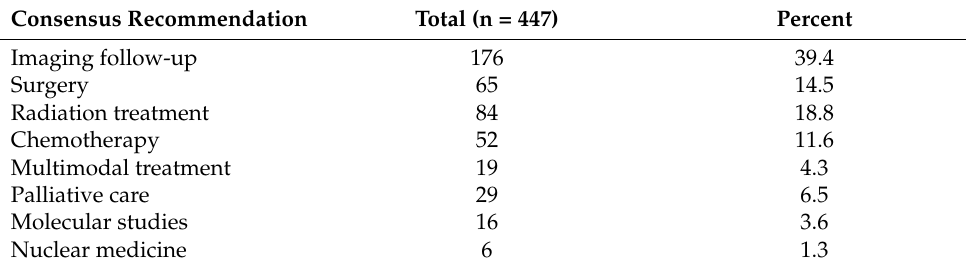
Table 2. Summary of the consensus recommendations after